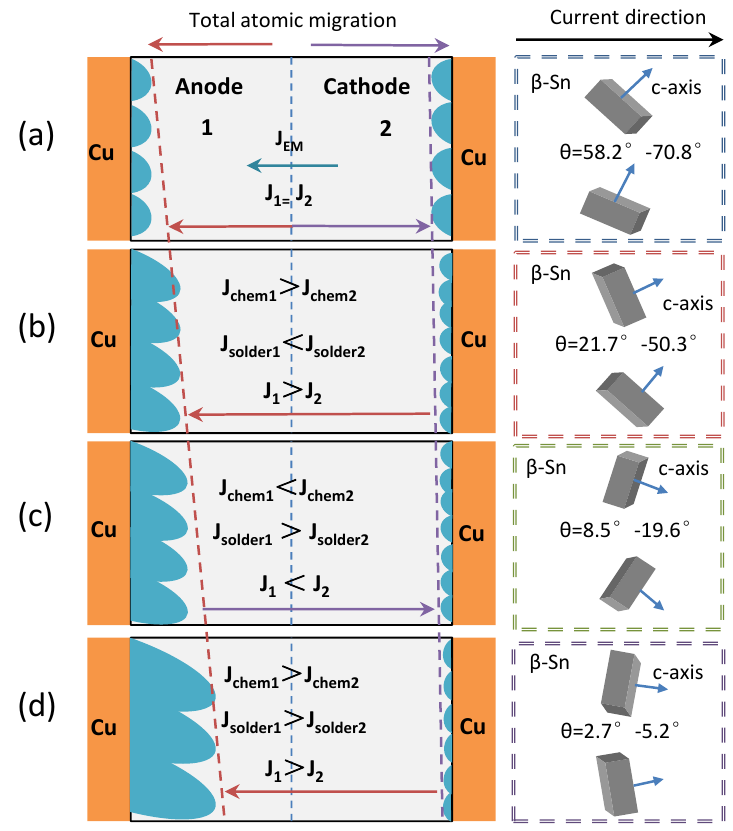
Figure 9. Electromigration mechanism: ( a ) t = 0 – 100 h; ( b ) t = 100 – 200 h; ( c ) t = 200 – 250 h; ( d ) t = 250 – 350 h.